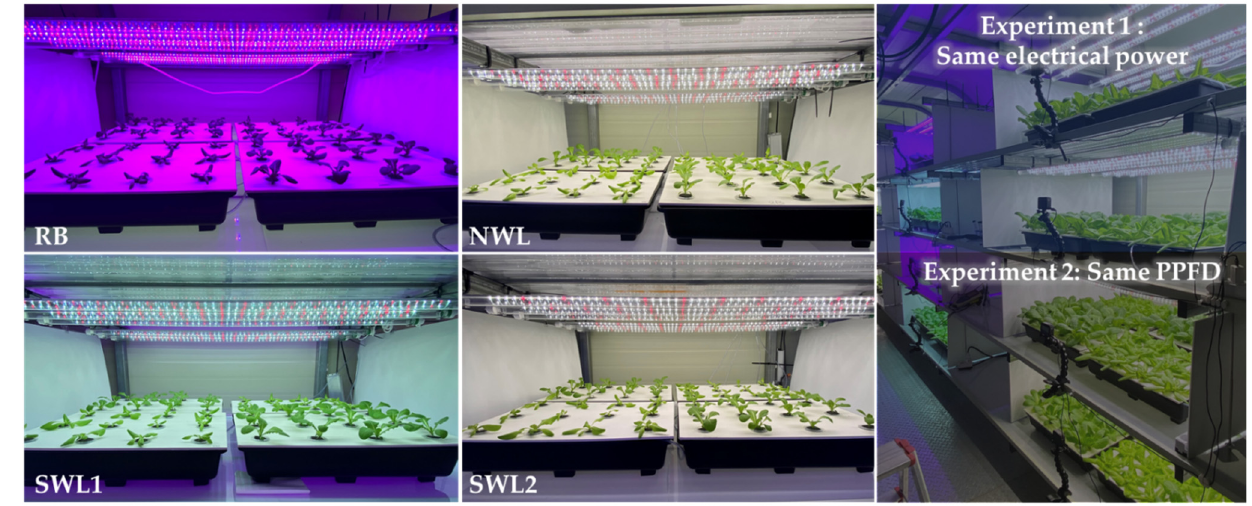
Figure 1 . Butterhead lettuce and romaine lettuce grown under various light sources: RB, NWL, SWL1, and SWL2. The electrical power was held constant in experiment 1 and the PPFD was held constant in experiment 2.